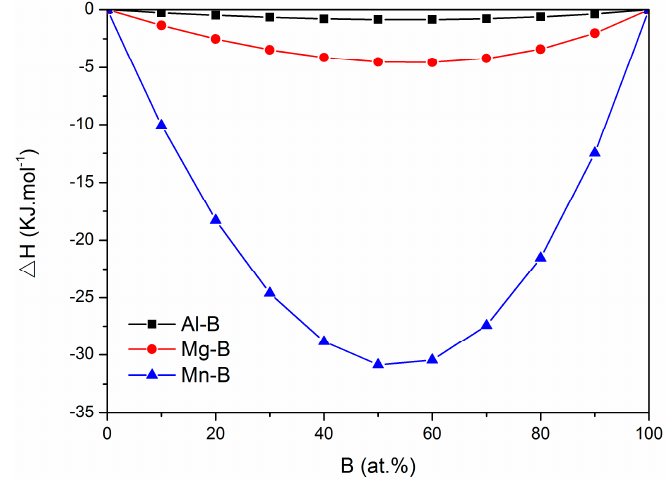
Figure 9. The enthalpies of Al-B, Mg-B and Mn-B Figure 9 . The enthalpies of Al-B, Mg-B and Mn-B compounds.